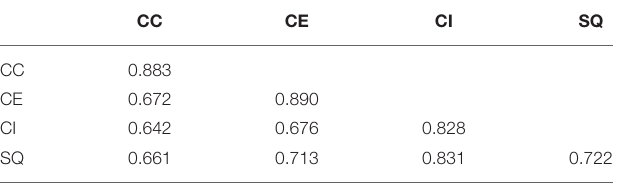
TABLE 3 | Fornell and larcker criteria.